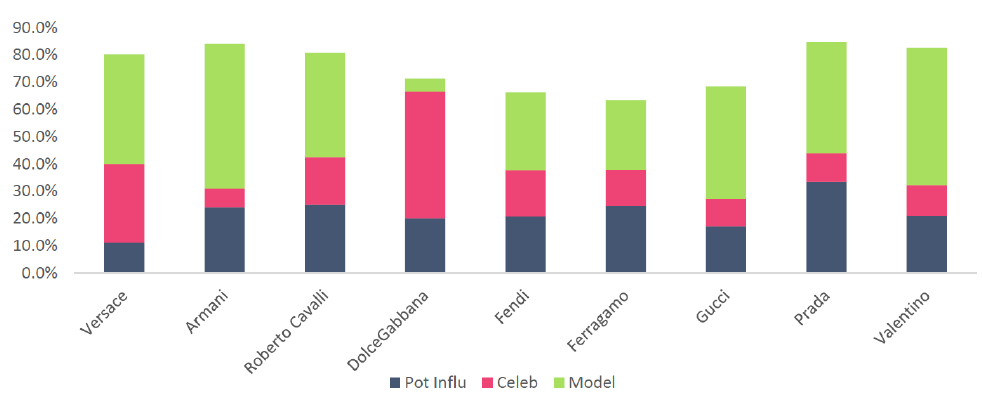
Figure 4. Share of each role (celebrity, potential influencer, and model) by each brand of the study.